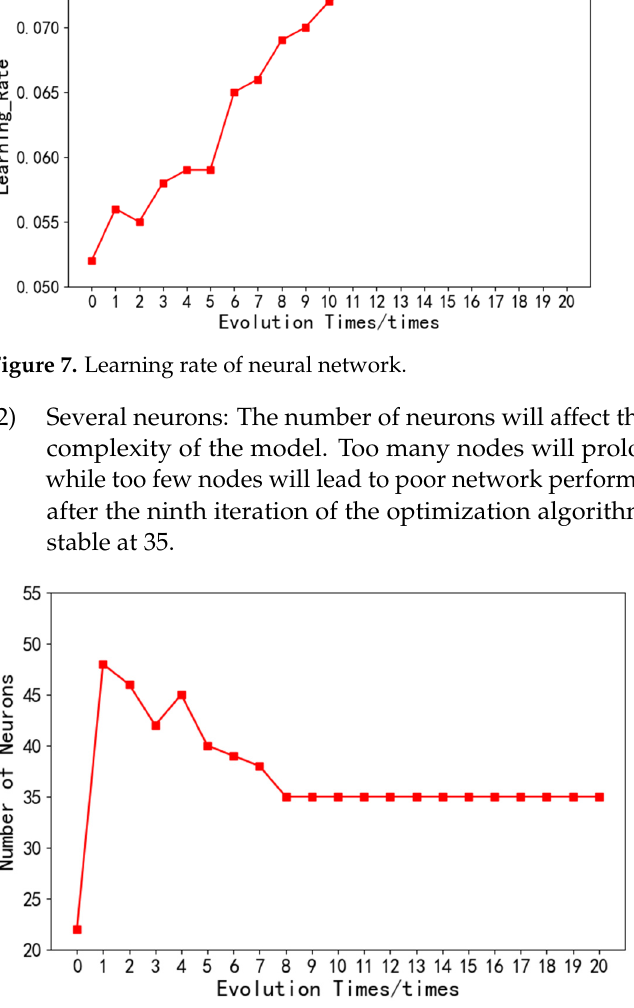
Figure 8. Data number of neurons.